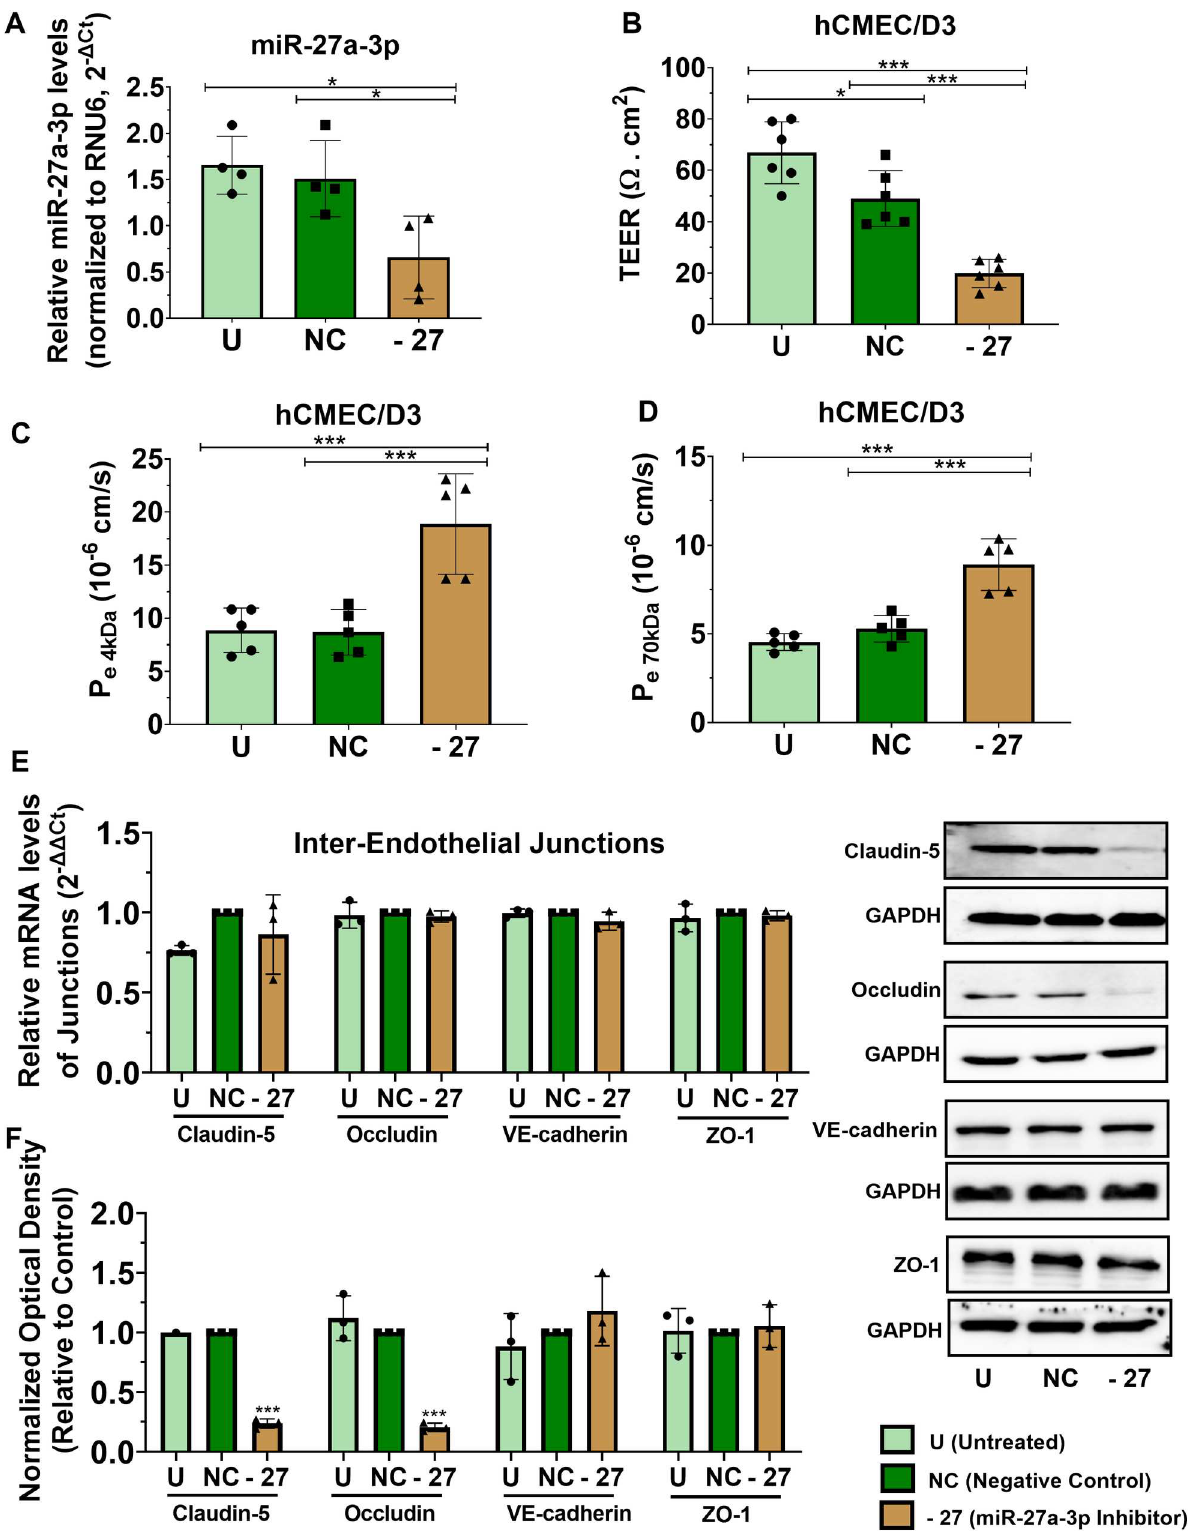
Fig 1. miR-27a-3p inhibitor increases the brain endothelial barrier permeability and downregulates claudin-5 and occludin protein expression. hCMEC/D3 cells were transfected with miR-27a-3p inhibitor or negative control for 72 hours. (A) miR-27a-3p relative expression measured by